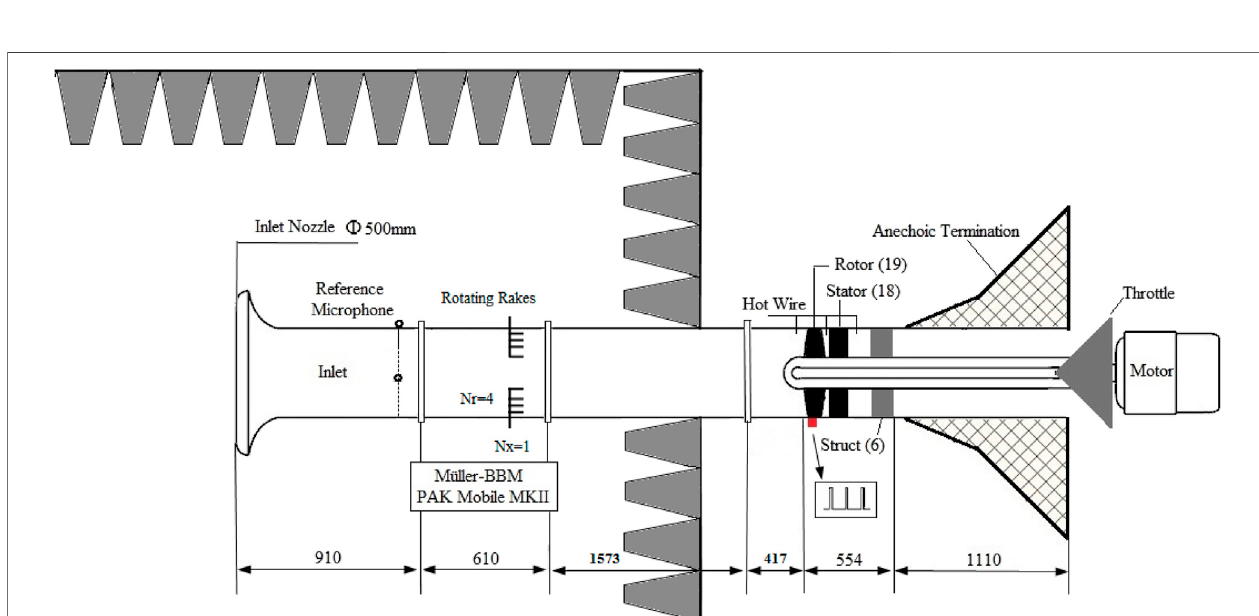
FIGURE 10 | Schematic diagram of the axial microphone array in experimental investigation.